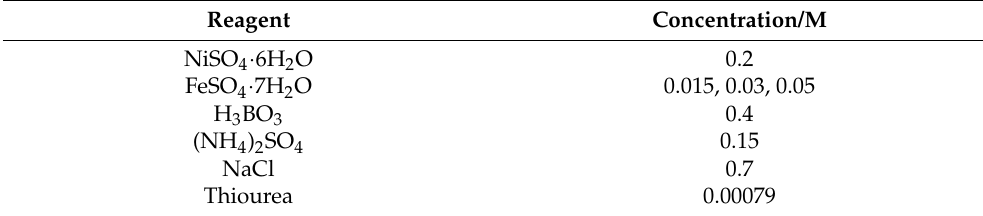
Table 1. Solution composition of electrodeposited FeNi films.